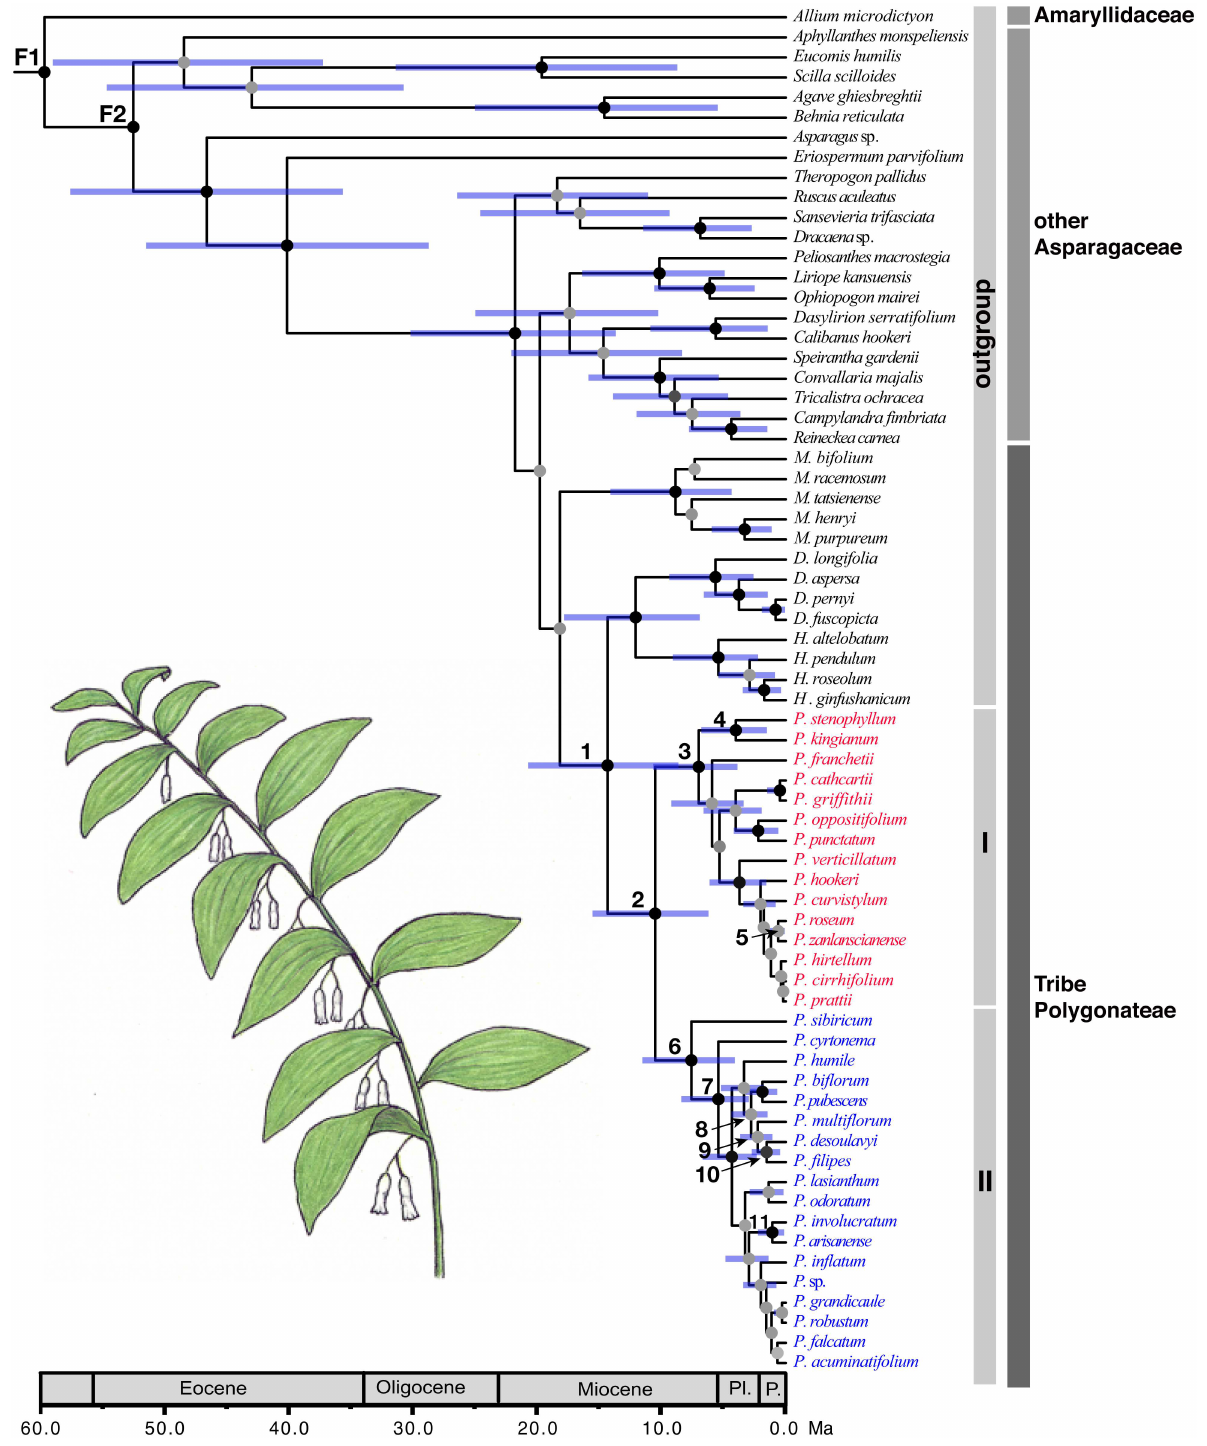
Fig 1. Maximum clade credibility tree of Polygonatum and the closely related taxa derived from a BEAST analysis. Posterior estimates of divergence times were inferred using a partitioned analysis of five combinedDNA regions (ITS, psbA-trnH , trnC-petN , rbcL , and matK ) and two fixes as normal age constraints (F1: 58.3 Ma; F2: 56.4 Ma). Nodes are posterior mean ages with blue node bars representing 95% highest posterior density intervals. Bayesian posterior probabilities < 0.95 are indicatedby grey and > 0.95 by black circles. Geological epoch abbreviations: Pl, Pliocene; P, Pleistocene. Inset: Polygonatum pubescens .